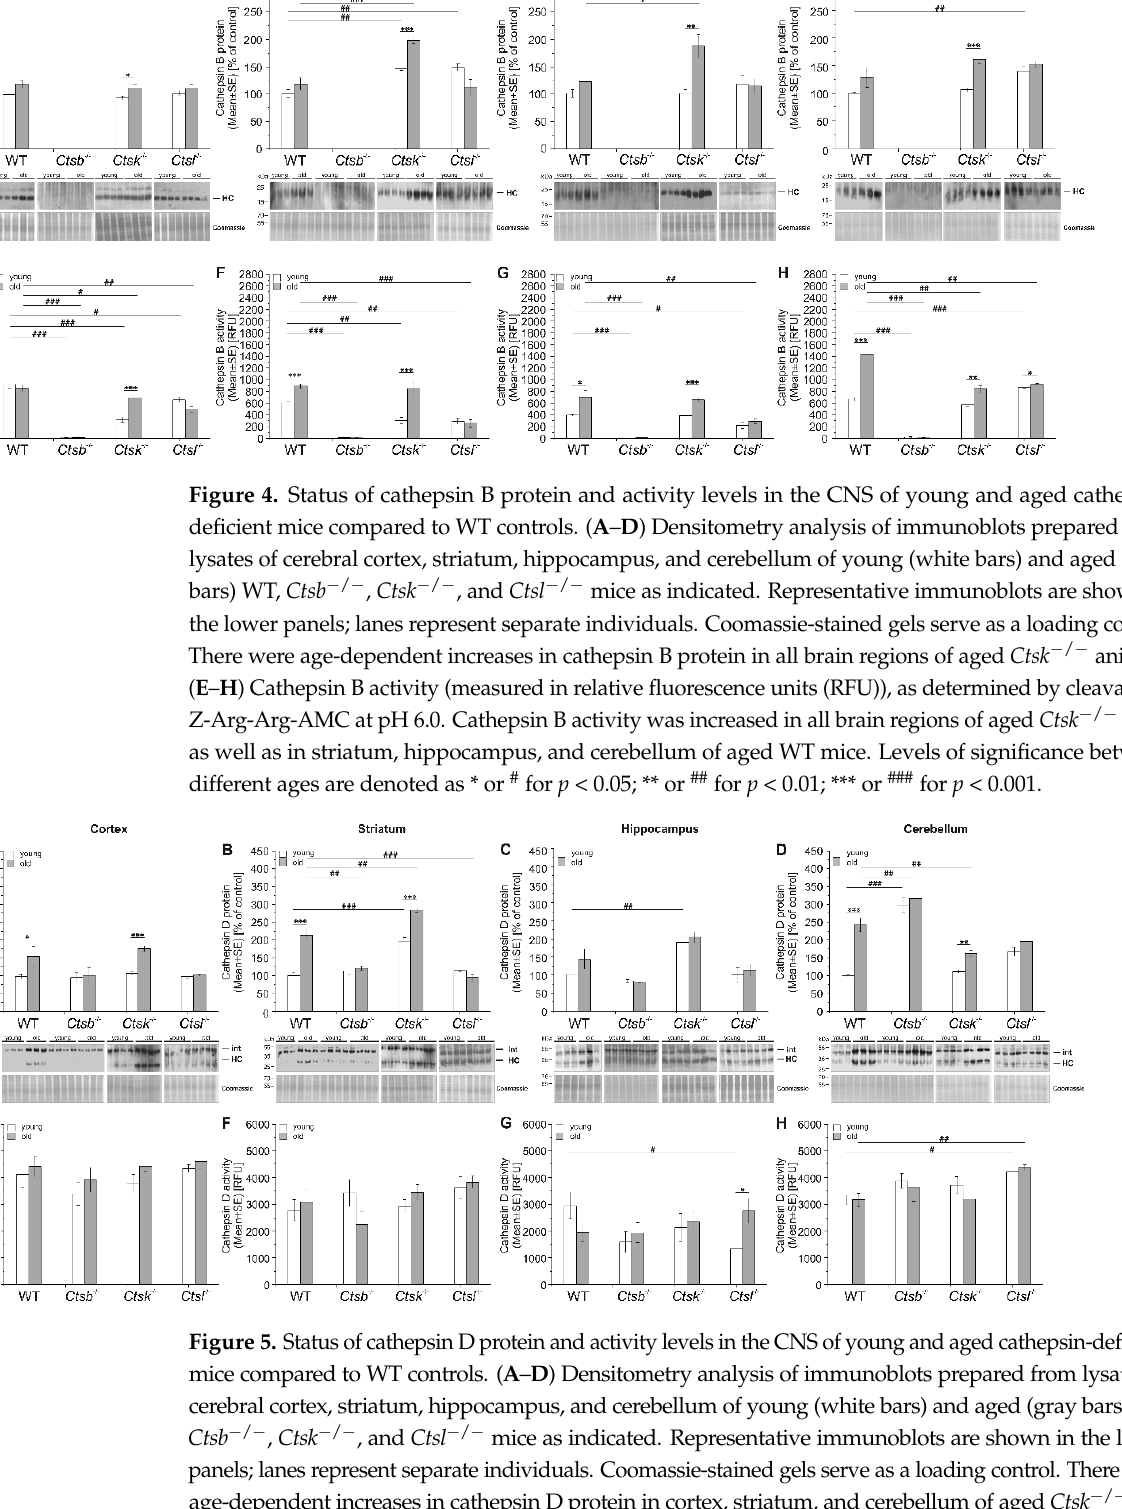
Figure 6. Status of cathepsin L protein and activity levels in the CNS of young and aged cathepsin- deficient mice compared to WT controls. ( A – D ) Densitometry analysis of immunoblots prepared from lysates of cerebral cortex, striatum, hippocampus, and cerebellum of young (white bars) and aged (gray bars) WT, Ctsb −/− , Ctsk −/− , and Ctsl −/− mice as indicated. Representative immunoblots are shown in the lower panels; lanes represent separate individuals. Coomassie-stained gels serve as a loading control. There were age-dependent increases in cathepsin L protein in striatum, hippocampus, and cerebellum of aged WT animals and in hippocampus and cerebellum of aged